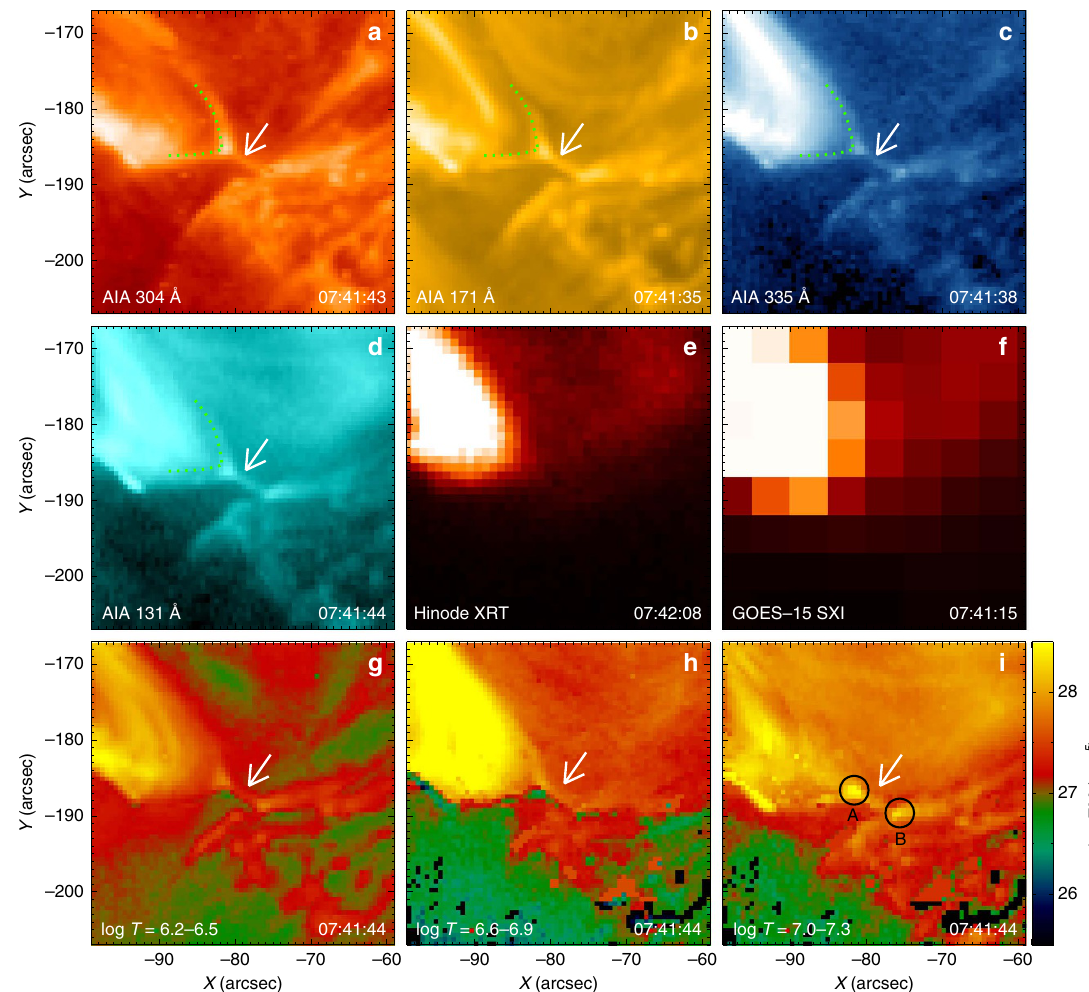
Figure 3 | EUV/X-ray images and EM maps. ( a – d ) AIA EUV images at 304, 171, 335 and 131Å channels, in which the cusp-shaped structures are marked by the dotted lines and the current sheet is indicated by the white arrows. ( e , f ) Cusp structure seen in X-ray images observed by Hinode/XRT and GOES/SXI, respectively. ( g – i ) EM maps in three temperature ranges showing the dominant temperatures of the inflow region, current sheet, cusps (encircled and marked ‘A’ and ‘B’ in i ), and reconnected Fig. 4a–c, which yield projected velocities along the lines marked in Fig. 2. Figure 4a shows the inward motions of loops, that is, the reconnection inflow. The apparent velocities of these loops are in the range of 3.7–25.0 km s (cid:2) 1 for the various filament threads on